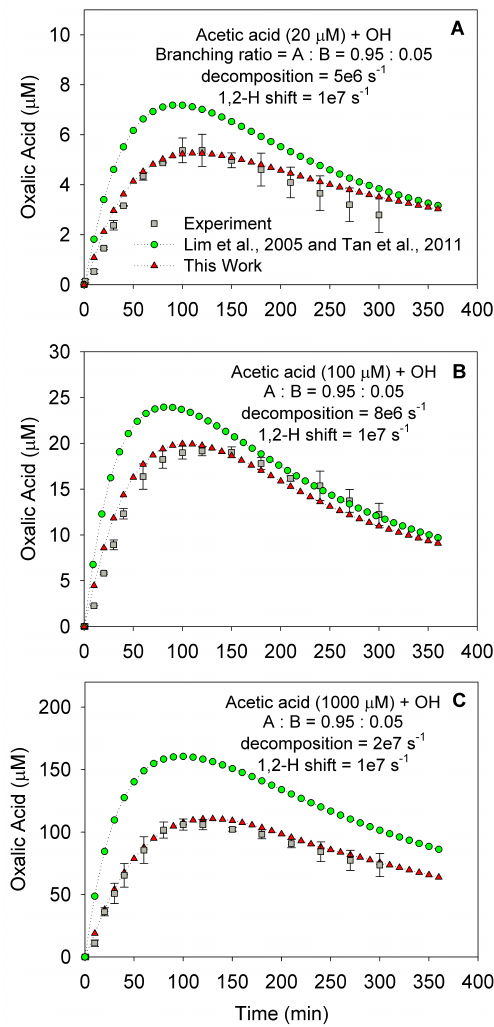
Fig. 7. Real-time profiles of oxalic acid produced from OH radical reactions of acetic acid at the initial acetic acid concentrations of 20µM (A) and 100µM (B) and 1000µM (C) ; experimental results (Tan et al., 2012) and previous/current model simulations (using the model of Lim et al., 2005; this